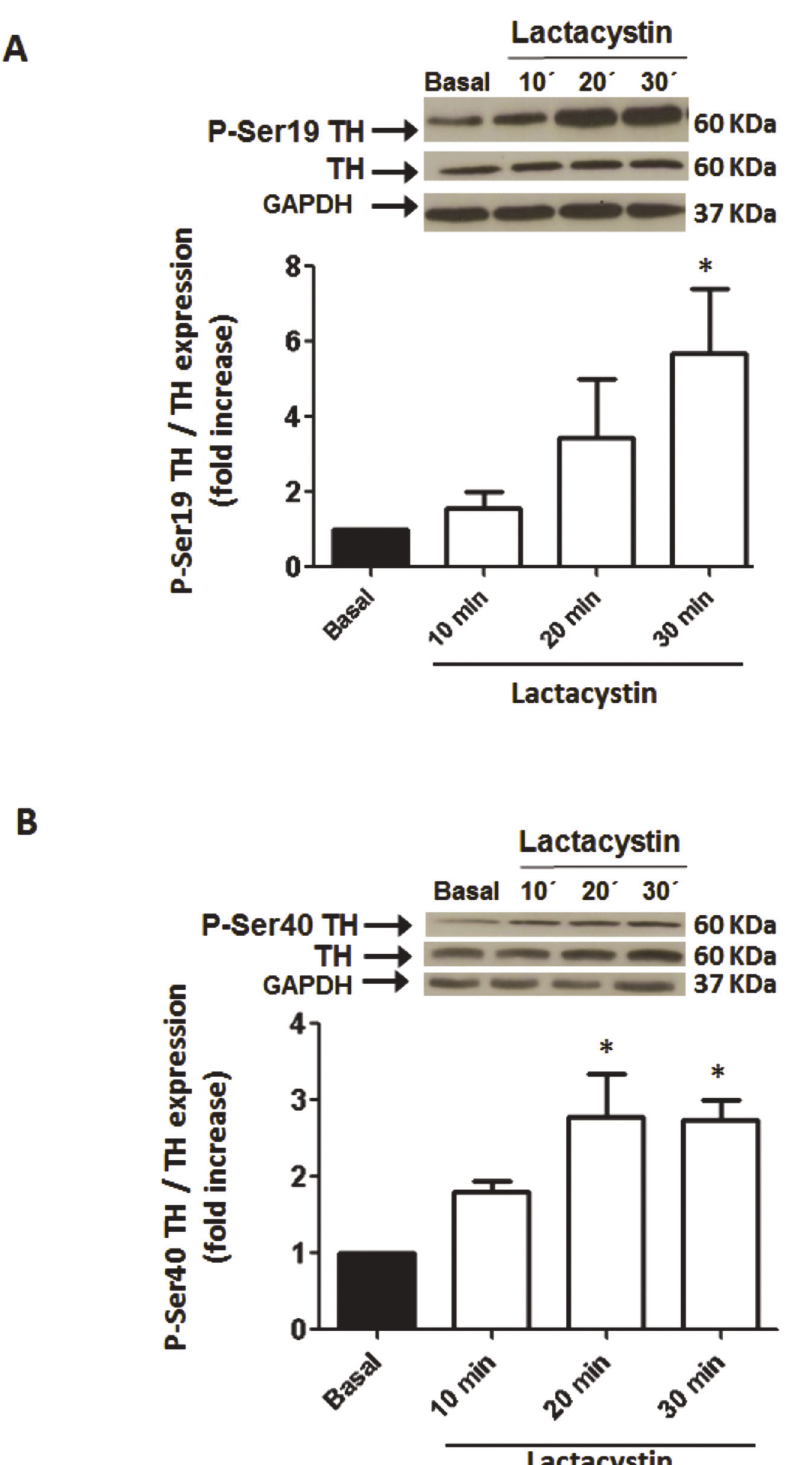
Fig 4. Effect of proteasome inhibition on TH phosphorylation at Ser19 (A) and Ser40 (B). PC12 cells were exposed to 1 μ mol/L lactacystin at different times and TH-phospho Ser19 or TH-phospho Ser40 were measured by Western-blot as described in Methods and normalized to TH protein level in the same sample. Protein loading was evaluated by reblotting the membrane with anti-GAPDH antibody and no differences